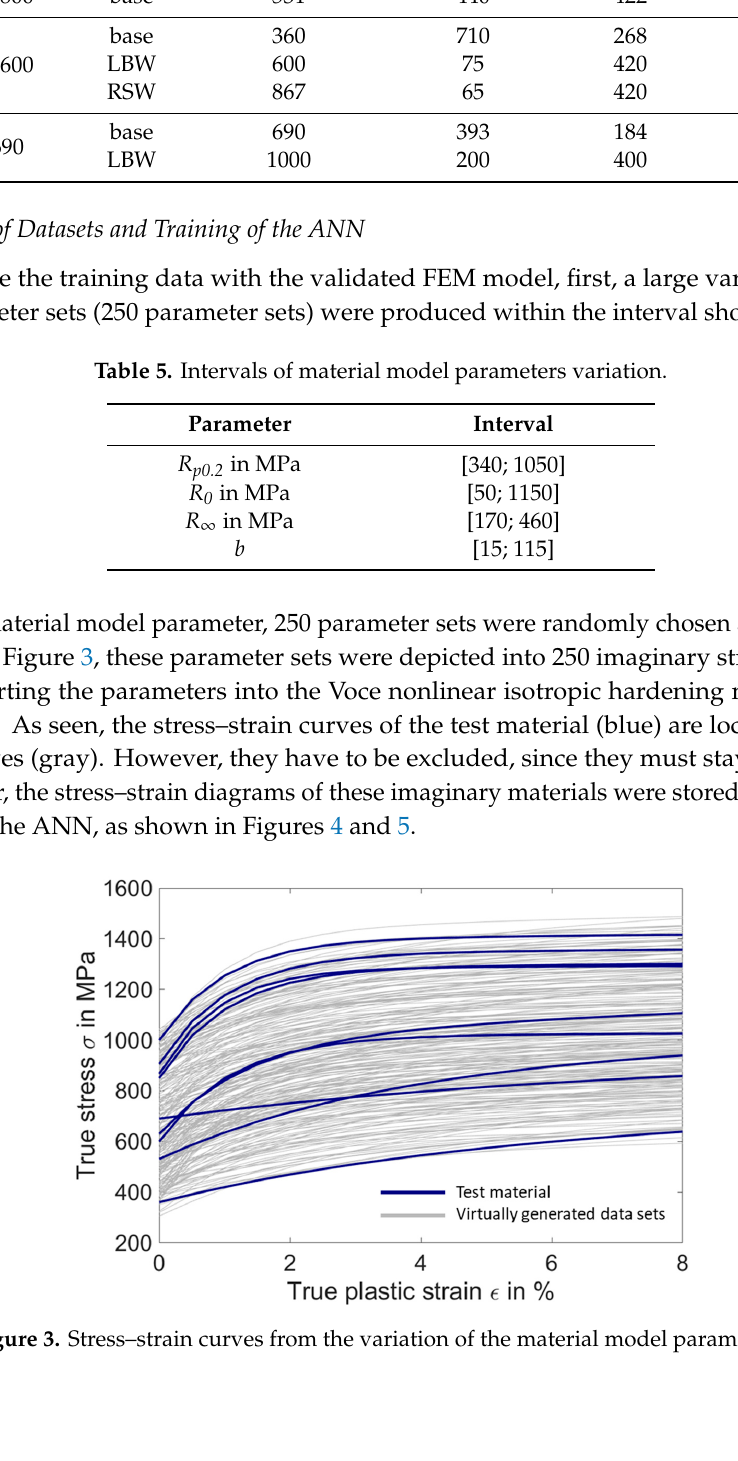
Table 4. Material model parameter sets for the validation of the ANN [45].